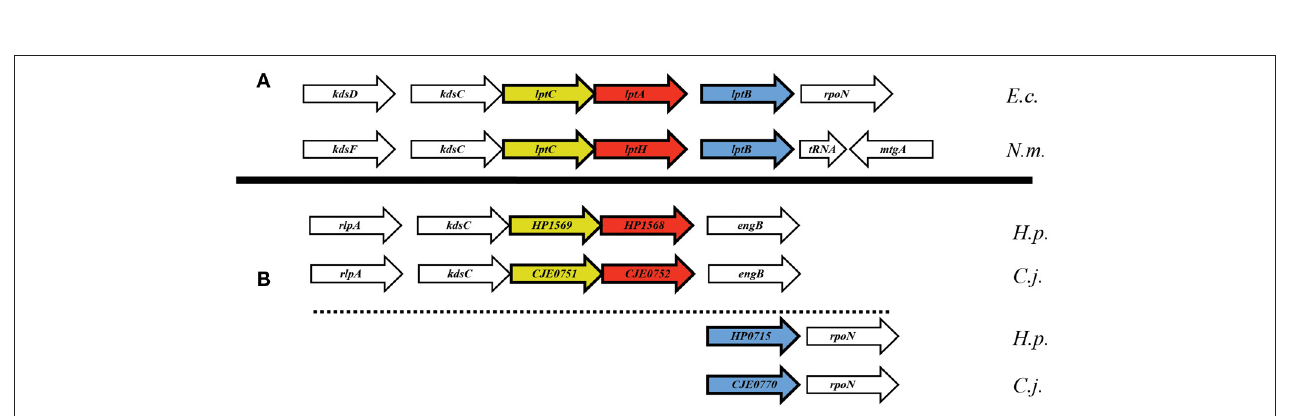
ε proteobacteria appears to have dissociated while still maintaining many of the genes proximal to the Lpt components, namely rpoN and kdsC